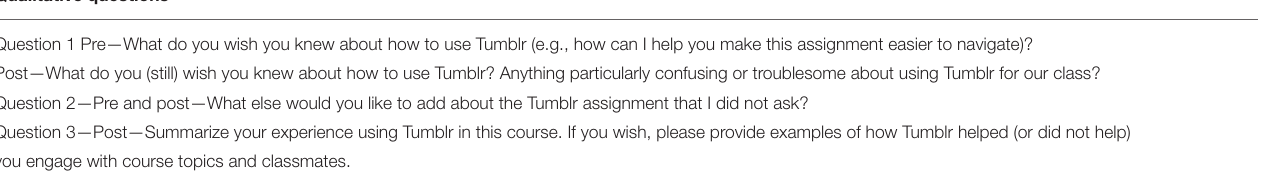
TABLE 4 | Qualitative questions and thematic analysis for a social media assignment used in information literacy undergraduate course at Montana State University ( n = 26). Qualitative